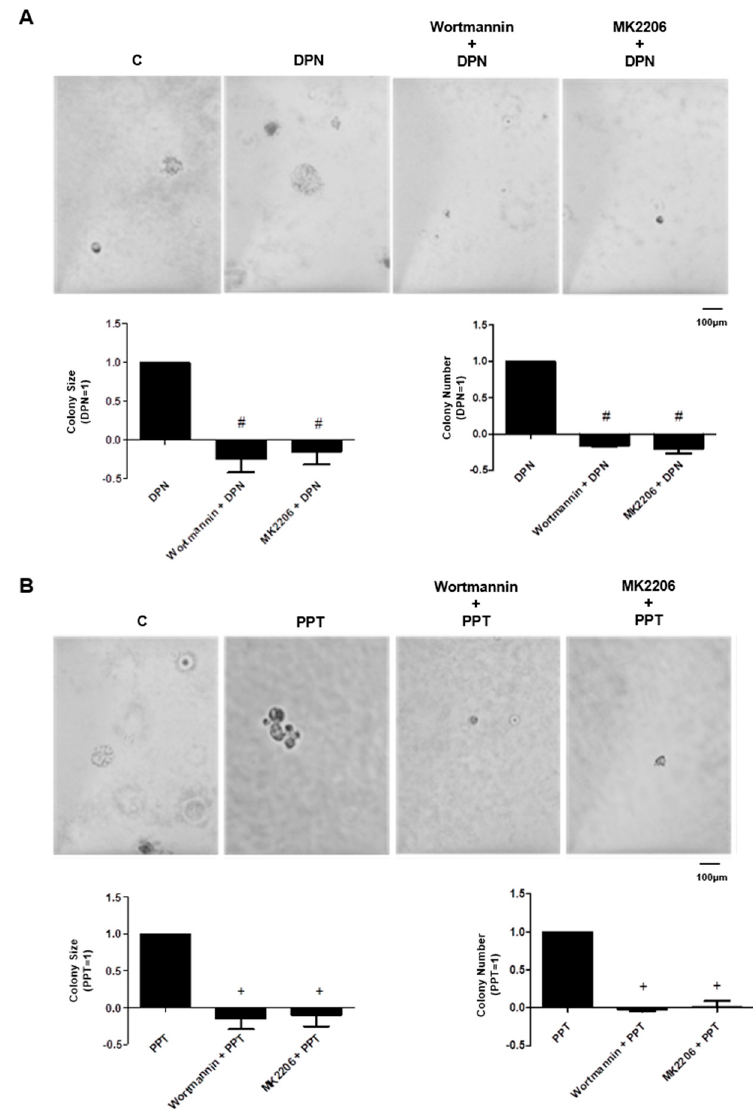
Figure 8. Effects of the PI3K specific inhibitors (Wortmannin) and AKT inhibitor (MK2206) on size and number of the colony formed by androgen-independent prostate cancer cells PC3 induced by DPN or PPT. Cells were incubated in the absence (C, control) and presence of DPN (10 nM) ( A ) and PPT (10 nM) ( B ) for 3 weeks at 37 °C. The cells were also pre-treated with Wortmannin (1 µM) or MK2206 (200 nM) for 30 min, and then incubated or not with DPN ( A ) or PPT ( B ). Representative image of PC-3 cell colony formation assays. The images were acquired, and the area of each colony was measured by the Image J software and the values obtained were expressed in relation to the DPN or PPT and subtracted from the control (DPN = 1) ( A ) or (PPT = 1) ( B ). The colonies were also counted with Zen software and the values of the number of colonies were expression in relation to DPN ( A ) or PPT ( B ) and subtracted from the control (DPN = 1) ( A ) or (PPT = 1) ( B ). Results are expressed as (mean ± SEM) of three independent experiments. # Significantly different from DPN ( p < 0.05, ANOVA and Newman-Keuls). + Significantly different from PPT ( p < 0.05, ANOVA and Newman-Keuls).